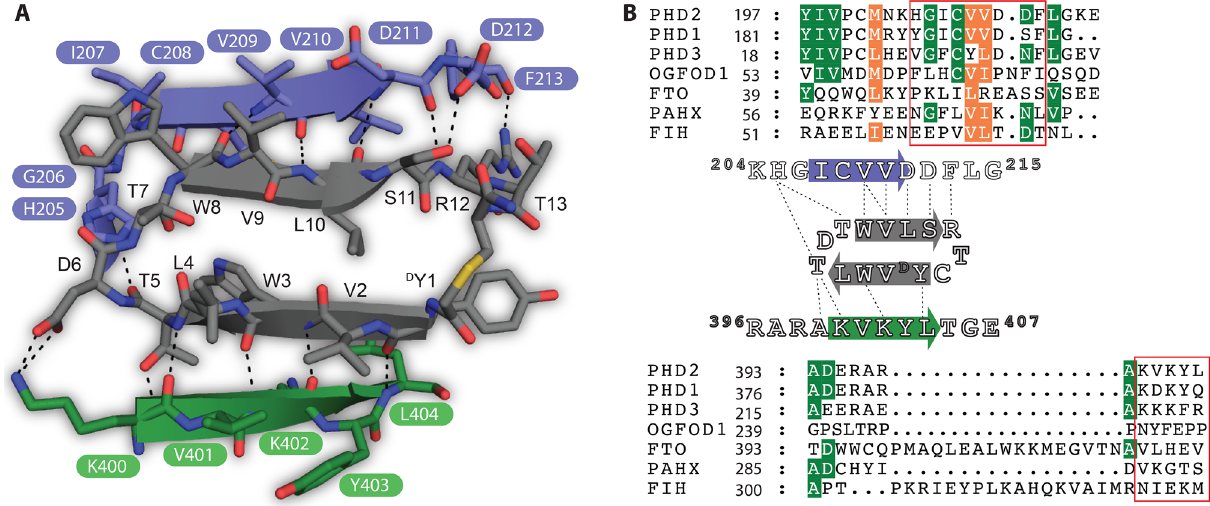
Figure 3. Structure based sequence alignment of 3C-ineracting residues in the PHDs and related oxygenases reveal the basis of its exquisite selectivity for the PHDs. ( A ) By contrast with many other macrocyclic peptide structures with a similar distorted β-sheet fold 31 , 3C has relatively few intramolecular interactions, but makes substantial more intermolecular interactions with cPHD2. 3C residues 8–11 from a parallel β-sheet with PHD2 β1 (aa 205–209) and 3C residues 1–4 form an anti-parallel β-sheet with PHD2 C -terminus (aa 400–404). Interestingly, binding of the 3C β-sheet to β1 of PHD2 extends the N -terminal side of double stranded β-helix (DSBH) core, which likely stabilizes its overall fold. ( B ) Structure based sequence alignment of 3C interacting regions (boxed black) in PHD1 (PDB: 5V1B), 2 and 3 with OGFOD1 (PDB: 4NHX), FTO (PDB: 4IE5), PAHX (PDB: 2A1X) and FIH (PDB: 1H2K) reveal that the 3C-binding residues are only conserved in PHDs. Dotted lines represent polar interactions of 3C with